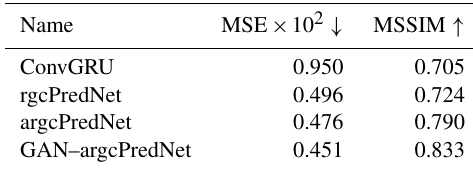
Table 5. MSE and MSSIM index scores of each